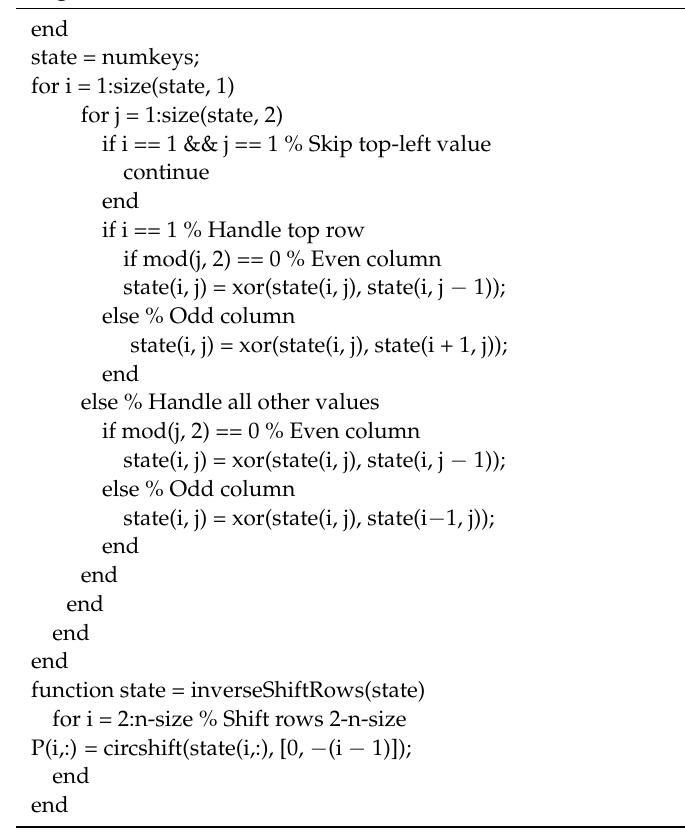
Algorithm A2. Cont.